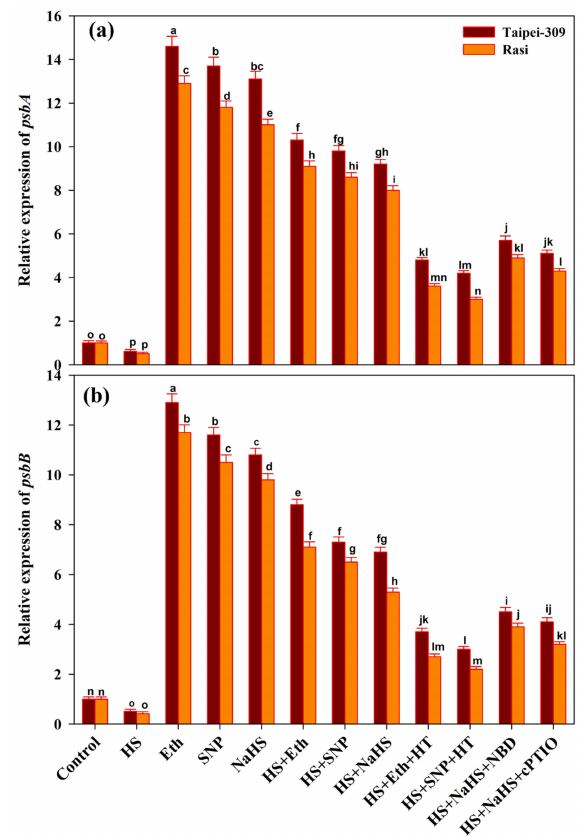
Figure 4. Relative expression of ( a ) psbA and ( b ) psbB of rice ( Oryza sativa L.) cultivars Taipei-309 and Rasi under control and high temperature stress (HS) supplied with 200 µ L L − 1 ethephon (Eth), 100 µ M sodium nitroprusside (SNP), 200 µ M sodium hydrosulfide (NaHS) or 100 µ M hypotaurine (HT), 100 µ M 2-4-carboxyphenyl-4,4,5,5-tetramethylimidazoline-1-oxyl-3-oxide (cPTIO), or 100 µ M norbornadiene (NBD) scavengers of hydrogen sulfide (H 2 S), nitric oxide (NO), and ethylene action inhibitors, respectively. Data are presented as treatments mean ± SE ( n = 4). The values followed by the same letters did not differ significantly by LSD test at p <